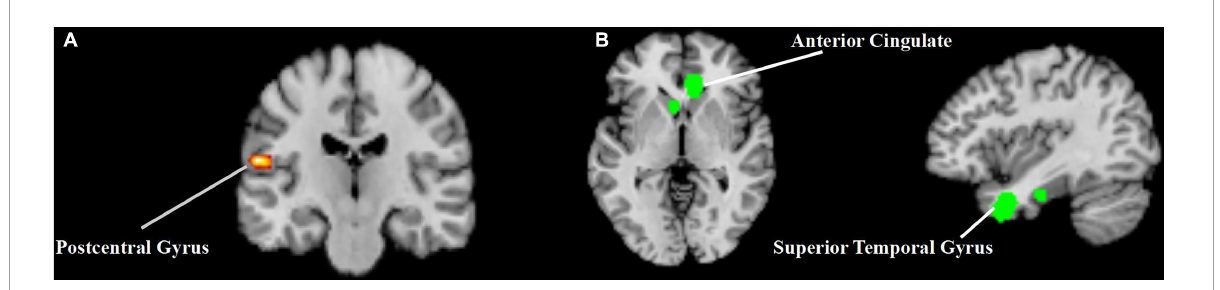
FIGURE2 The results of the activation likelihood estimation (ALE) analysis from acupuncture at Hegu . (A) The activation likelihood estimation (ALE) analysis result of the activation patterns of acupuncture at Hegu . (B) The activation likelihood estimation (ALE) analysis result of the deactivation patterns of acupuncture at Hegu